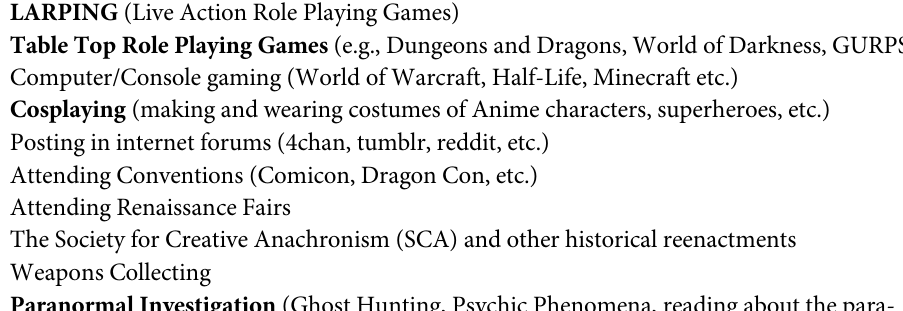
Table Top Role Playing Games (e.g., Dungeons and Dragons, World of Darkness,